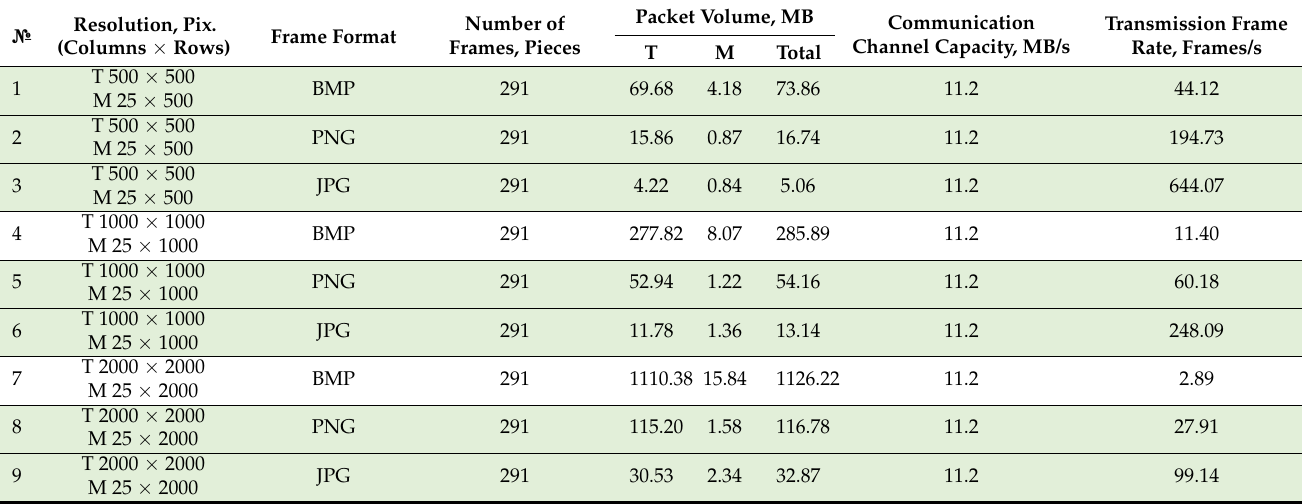
Table 1. Time of packet transmission and transmission frame rate.